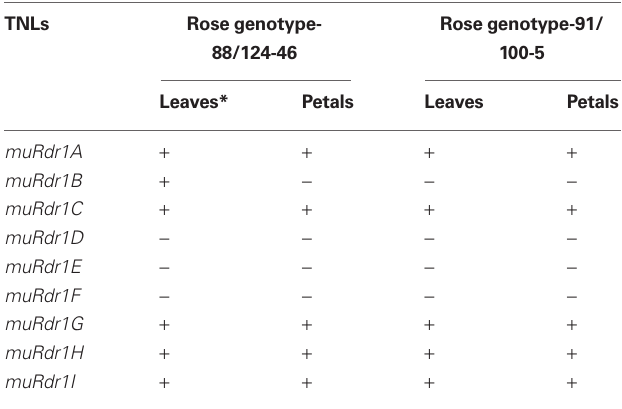
Table 3 | expression profiles of single muRdr1 TNLs in a homologous system.